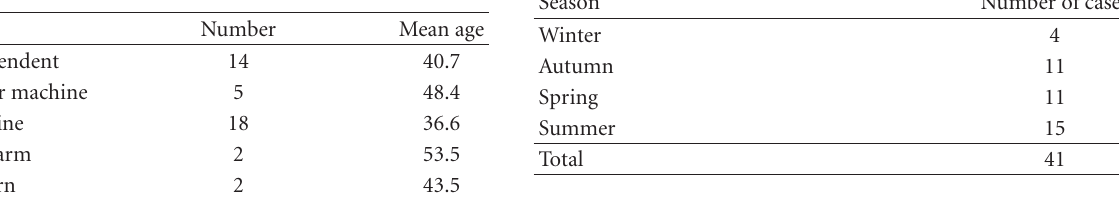
Table 2: The distribution of the etiologic factors and mean age- etiology relationship of the farm injured patients.